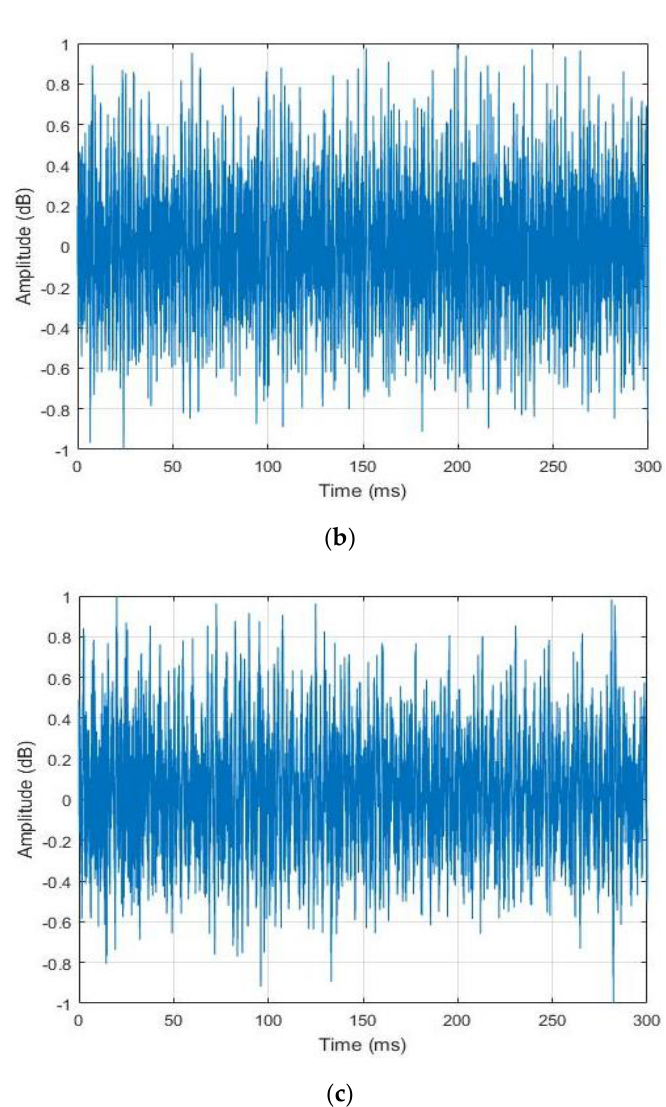
Figure 5. Example of the data samples collected for the experiments: ( a ) idle data; ( b ) normal data; and, ( c ) abnormal data. Each data has a length of 300 milliseconds.